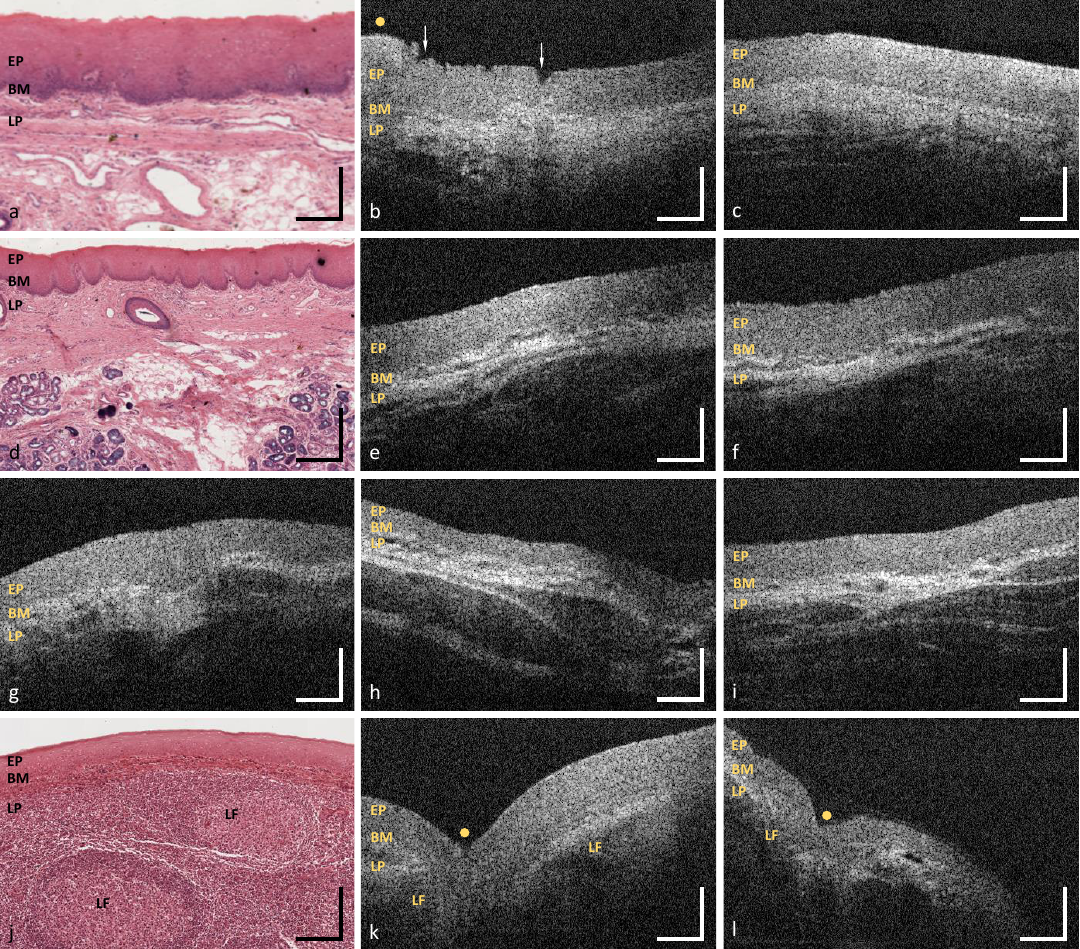
Figure 10. OCT images of the hard palate (MP12) ( b , c ), the soft palate (MP13) ( e,f ), the uvula (MP14) ( g ), the oropharynx (MP15) ( h , i ) and the palatine tonsil (MP16) ( k , l ). Exemplary HE stained histological cross sections depicting the hard palate ( a ), the soft palate ( d ) and the palatine tonsil ( j ) ([44] modified). EP: epithelium, BM: basement membrane, LP: lamina propria, LF: lymphoid follicle; Arrows: epithelial alteration, Yellow dots: palatal ridges and tonsillar crypts. Scale bars: 200 µ